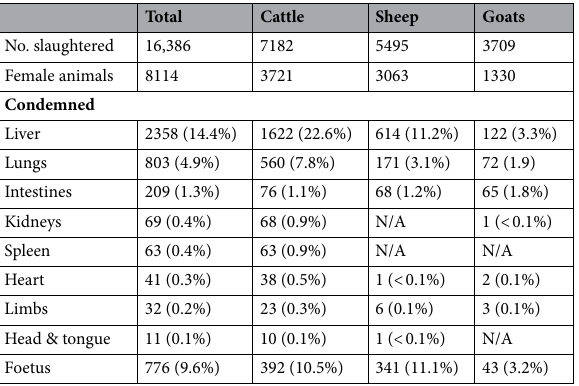
Table 2. The number (and overall proportion) of condemnations of each organ, overall and in each animal species, in two slaughterhouses in Bungoma County, western Kenya, between 17th March 2017 and 31st December